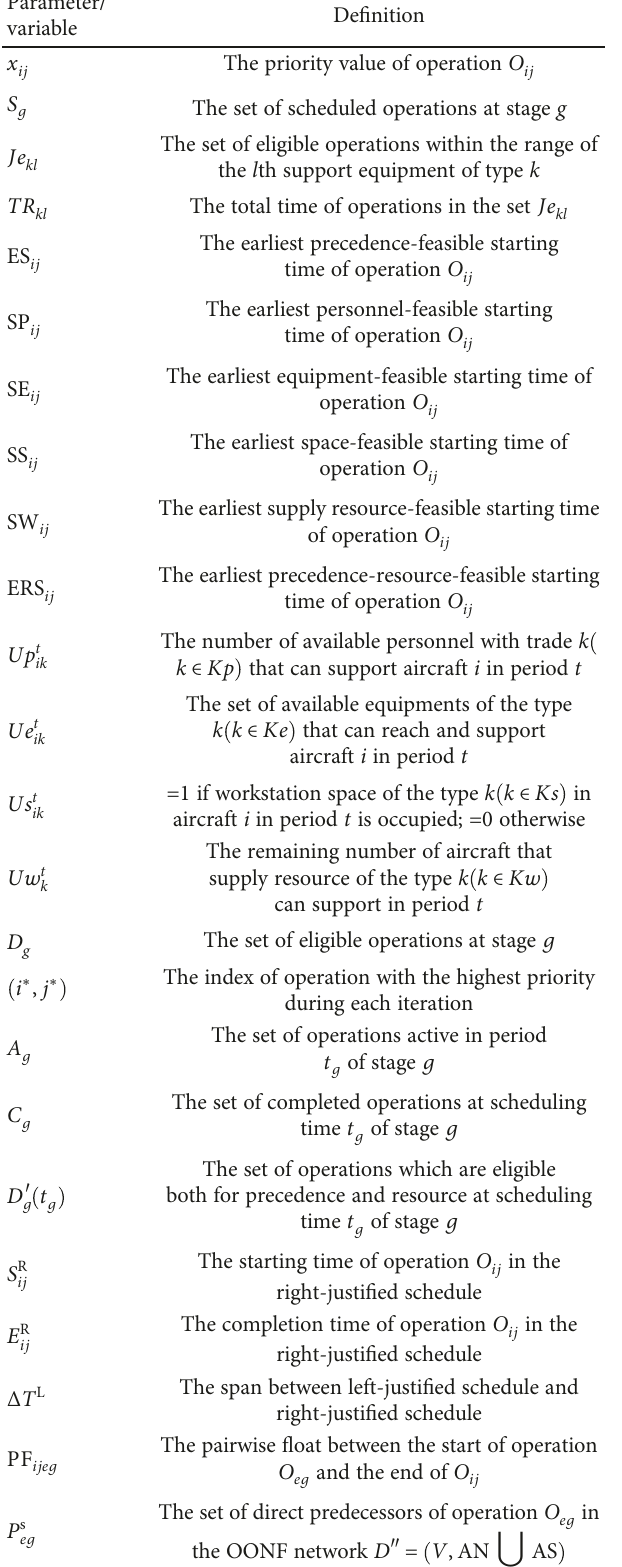
Table 3: Notation for scheduling and allocation scheme.